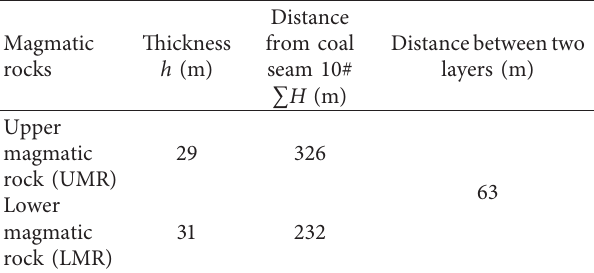
Table 1: Parameters of double layers of magmatic rock above panel